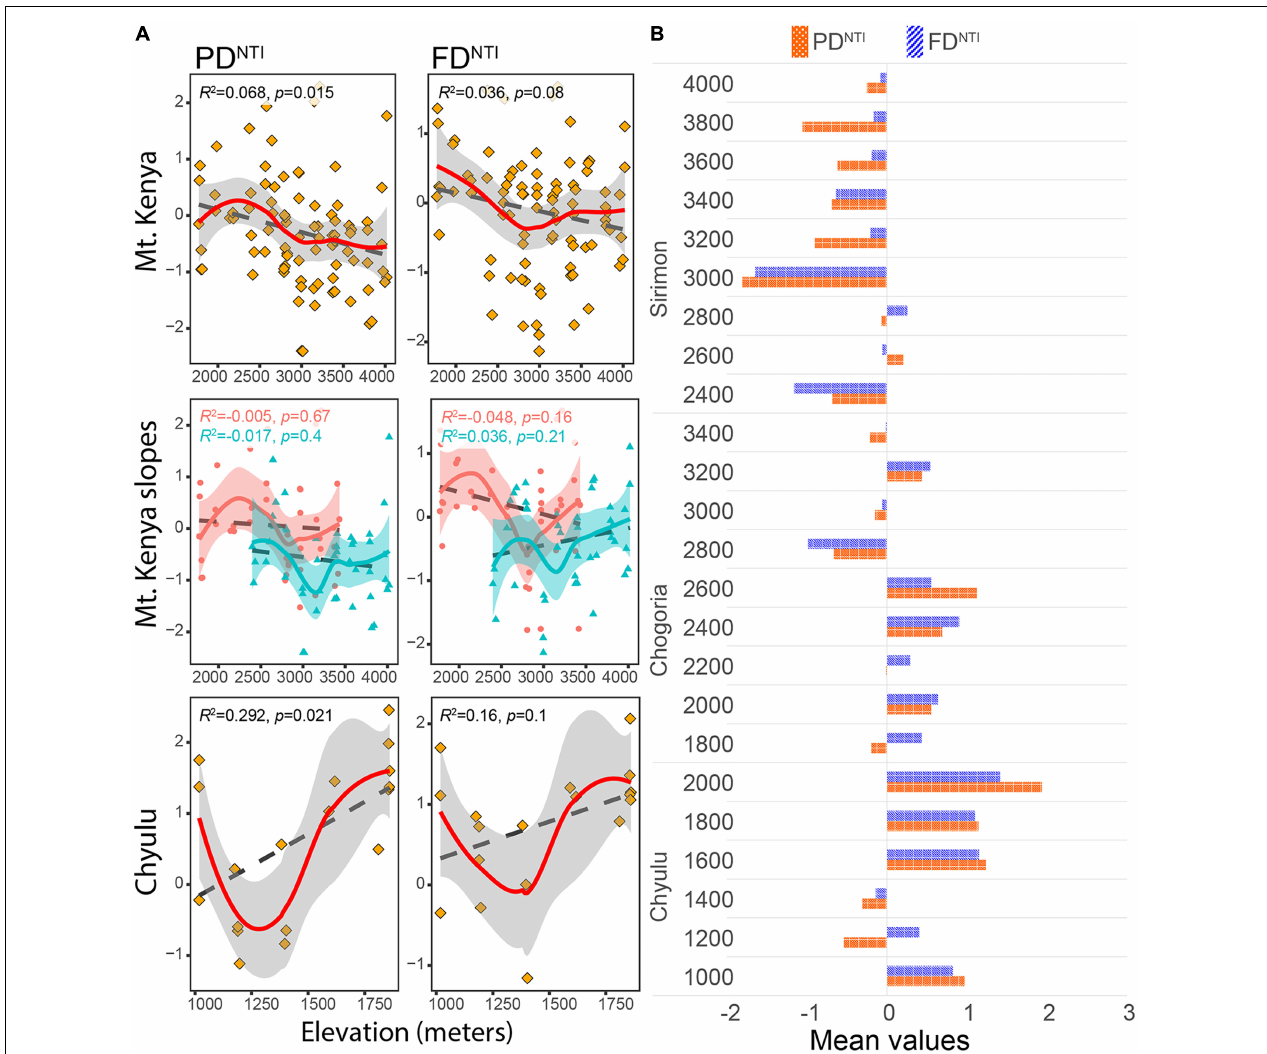
FIGURE 3 | The distribution of phylogenetic and functional community structure indices along elevational gradients in Mt. Kenya and the Chyulu Hills. (A) The association of community structure ( y -axes) with elevation ( x -axes) between elevational gradients. (B) The distribution of mean structure indices between the transects. Points represent traplines and lines represent the local polynomial (colored continuous lines) and GLM (black dashed line) regression lines. In the Mt. Kenya plots, light red-colored dots represent Chogoria traplines while the dark shade of cyan triangular points represents Sirimon